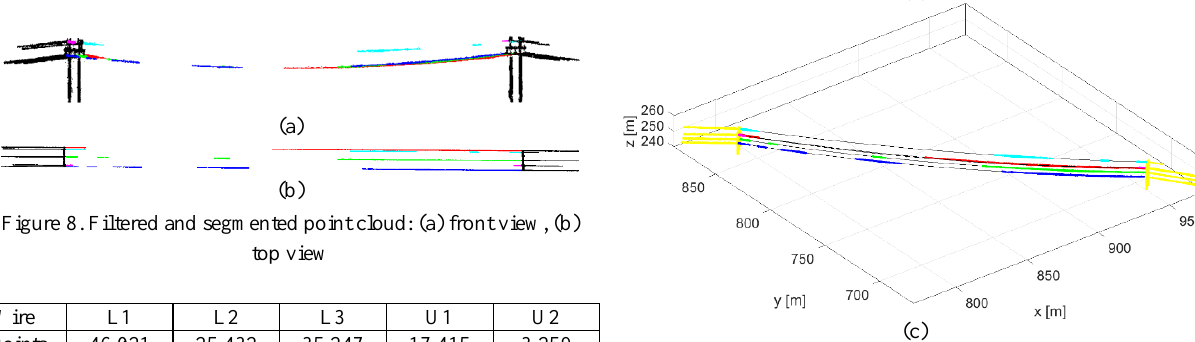
Figure 8. Filtered and segmented point cloud: (a) front view, (b) top view